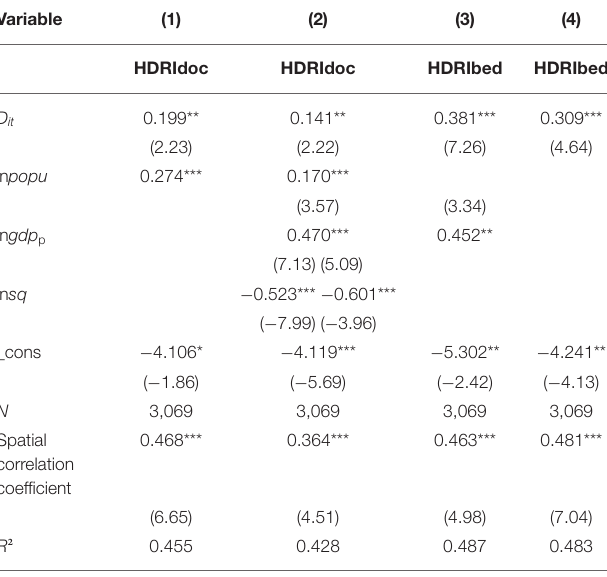
TABLE 6 | Estimation results of spatial DID model. TABLE 7 | Regression estimation results of robustness